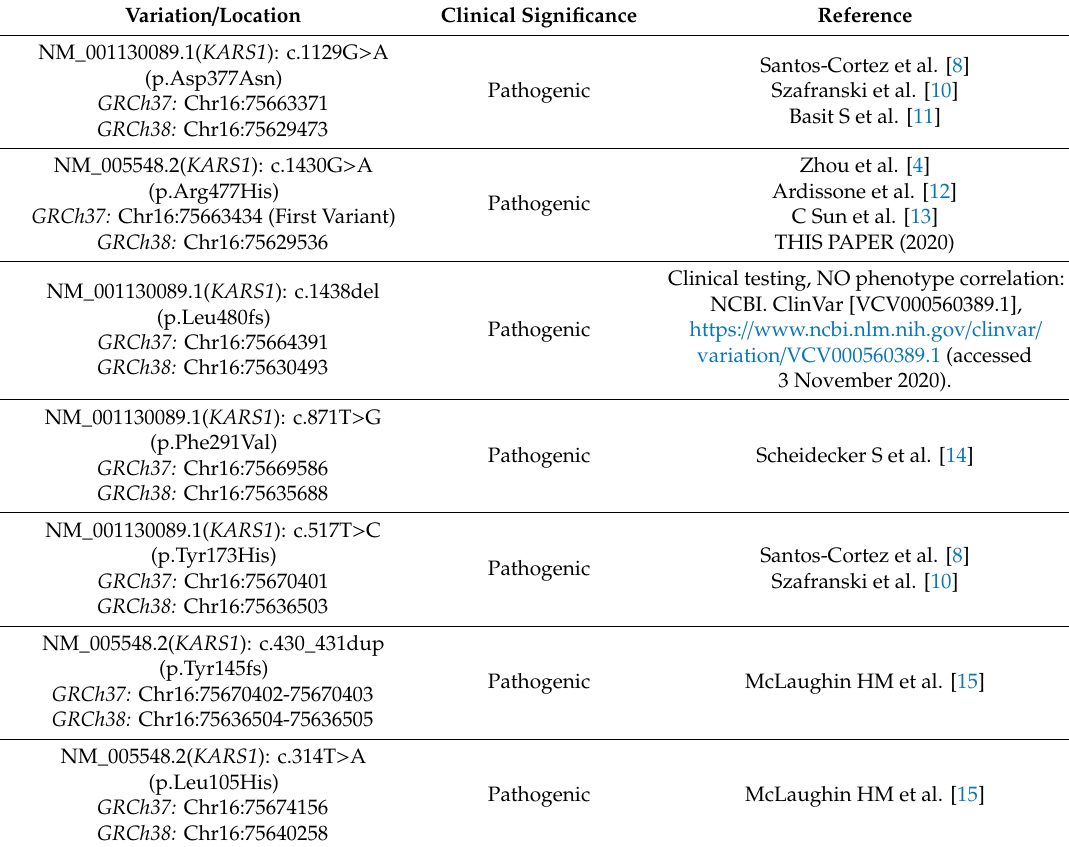
Table 1. Current KARS1 gene variations documented up until this day. Relation to their clinical significance and the available